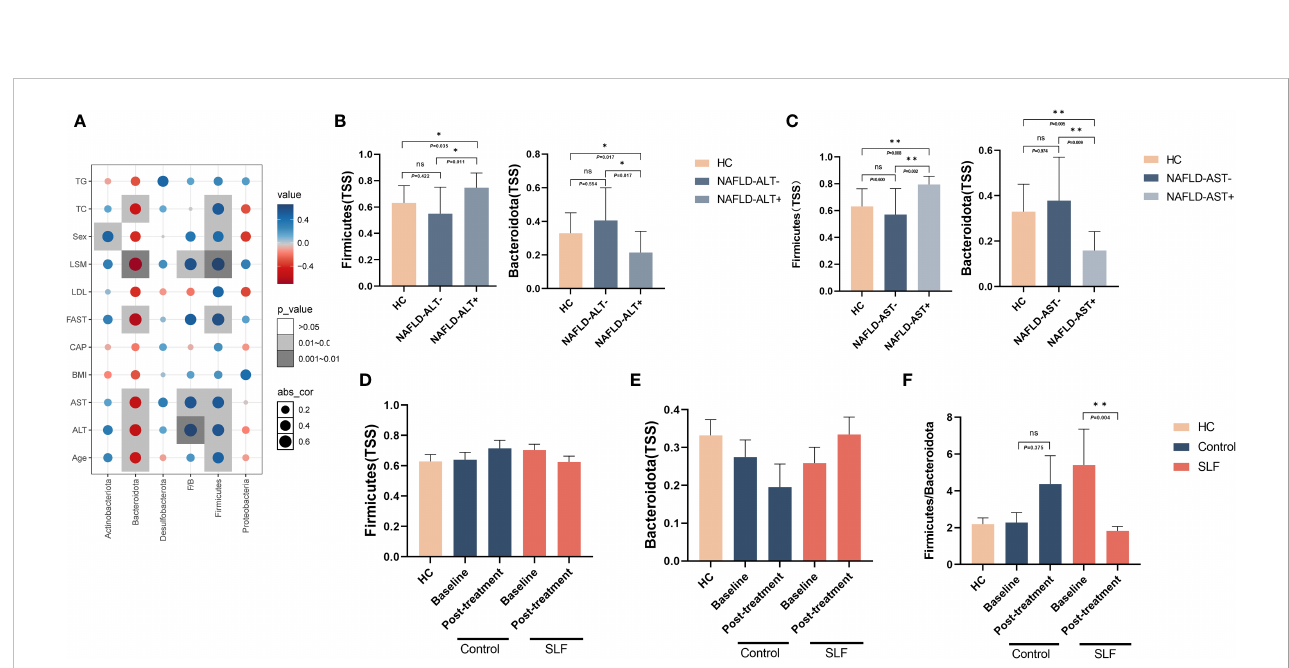
FIGURE 6 Intestinal fl ora were correlated with clinical indicators of NAFLD, and SLF might play a role in regulating Firmicutes and Bacteroidetes . (A) Correlation analysis between Firmicutes , Bacteroidetes , Actinobacteriota , Desulfobacterota , Proteobacteria and F/B with FibroTouch, lipids, glucose, gender, age, liver function and FAST score. (B) Comparison of Firmicutes and Bacteroidetes levels by ALT subgroup. (C) Comparison of Firmicutes and Bacteroidetes levels by AST subgroup. (D) Changes in Firmicutes levels in the two groups before and after treatment. (E) Changes in Bacteroidetes levels in the two groups before and after treatment. (F) Changes in F/B in the two groups before and after treatment. F/B: The ratio of Firmicutes and Bacteroidetes . TSS, Total-sum normalization. ns, no signi fi cance. * P < 0.05 and ** P <